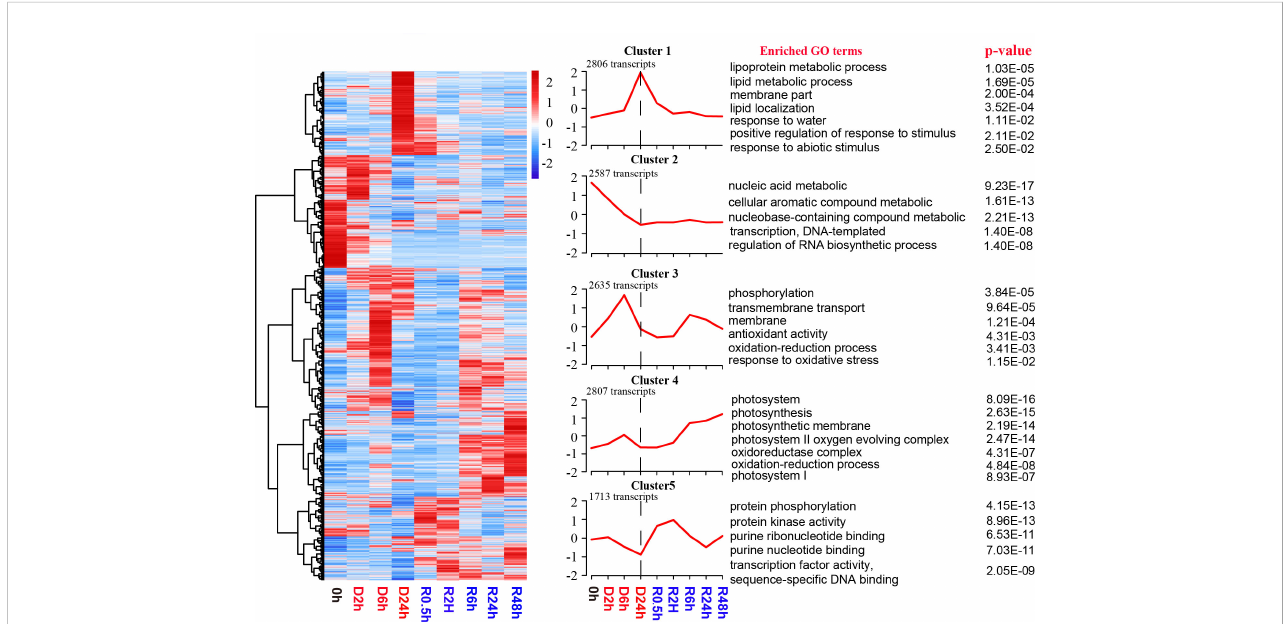
FIGURE 3 Global transcript abundance pro fi ling of S. caninervis gametophyte during D-R process. |Log 2 (Fold Change)| ≥ 1 and p-value ≤ 0.05 were used as the threshold to select DETs; FPKM of DETs values are used for the heatmap, which up- and down-regulated are indicated in red and blue respectively; K- means clustering graph of DETs based on Z-score standardization of differential transcripts; DETs were clustered into fi ve clusters by the K-means clustering (Cluster1-Cluster5). The number of transcripts in each cluster was showed at the top right-hand corner of each cluster. GO enrichment analysis of the fi ve clusters and displaying signi fi cant GO terms with p ≤